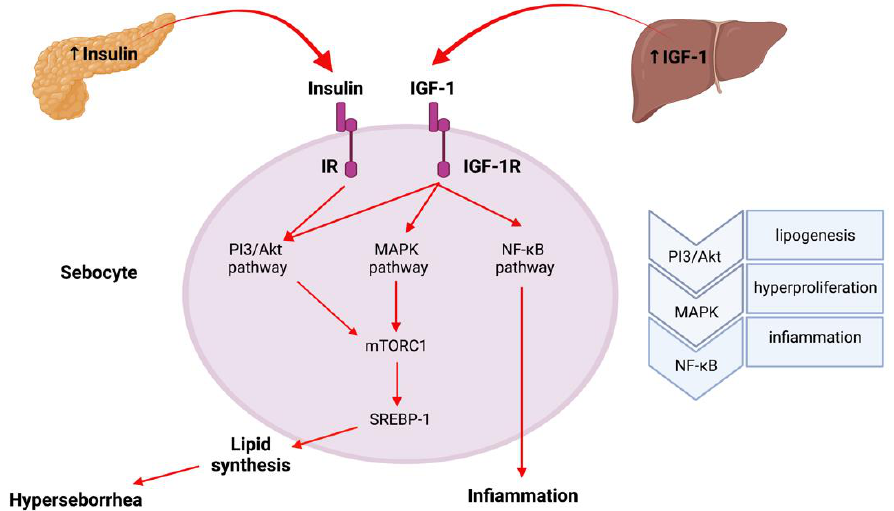
Figure 2. Insulin–IGF-1 action at the sebaceous gland level: Insulin and the IGF-1 induce lipid synthesis by increasing the SREBP-1 expression via the PI3K/Akt/FoxO1/mTORC1 pathway and MAPK pathway. The IGF-1 may induce the proinflammatory cytokine expression in sebocytes, activating the NF- κ B activity. (AMPK: AMP-activated protein kinase, NF- κ B: nuclear factor kappa B, SREBP-1: sterol regulatory element-binding protein 1, PI3: phosphatidylinositol-3-kinase, Akt: protein kinase B, mTORC1: mammalian target of rapamycin complex 1).